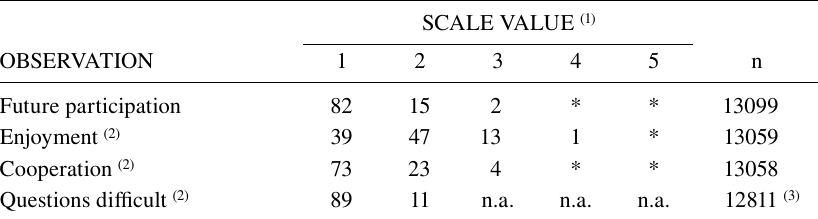
Percentage distributions of interviewer observations